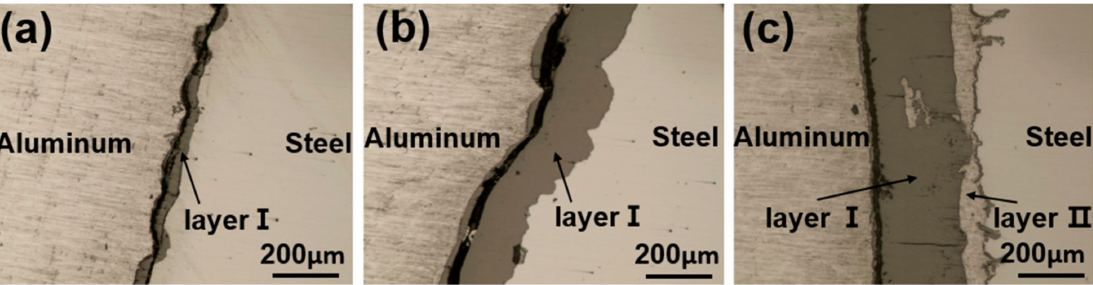
Figure 8. Micrographs of the joining zone between steel and aluminum under different deformation degrees: ( a ) 50%, ( b ) 70%, ( c ) 90%.